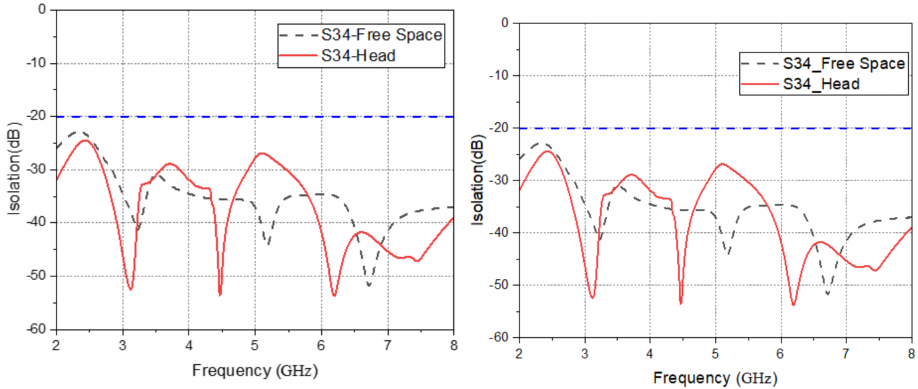
Figure 31. Isolation for simulated Ant. 3 and Ant. 4 in free space and when worn on the head.